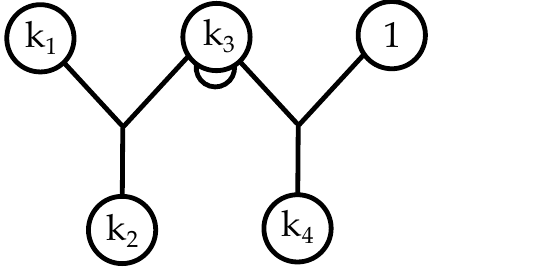
Figure 10 . Quiver for two coupled trinions and an adjoint at the central node indicated by the arc. We denote this quiver by (cid:10) ( k 1 ;k 2 ;k 3 ;k 4 ; 1)